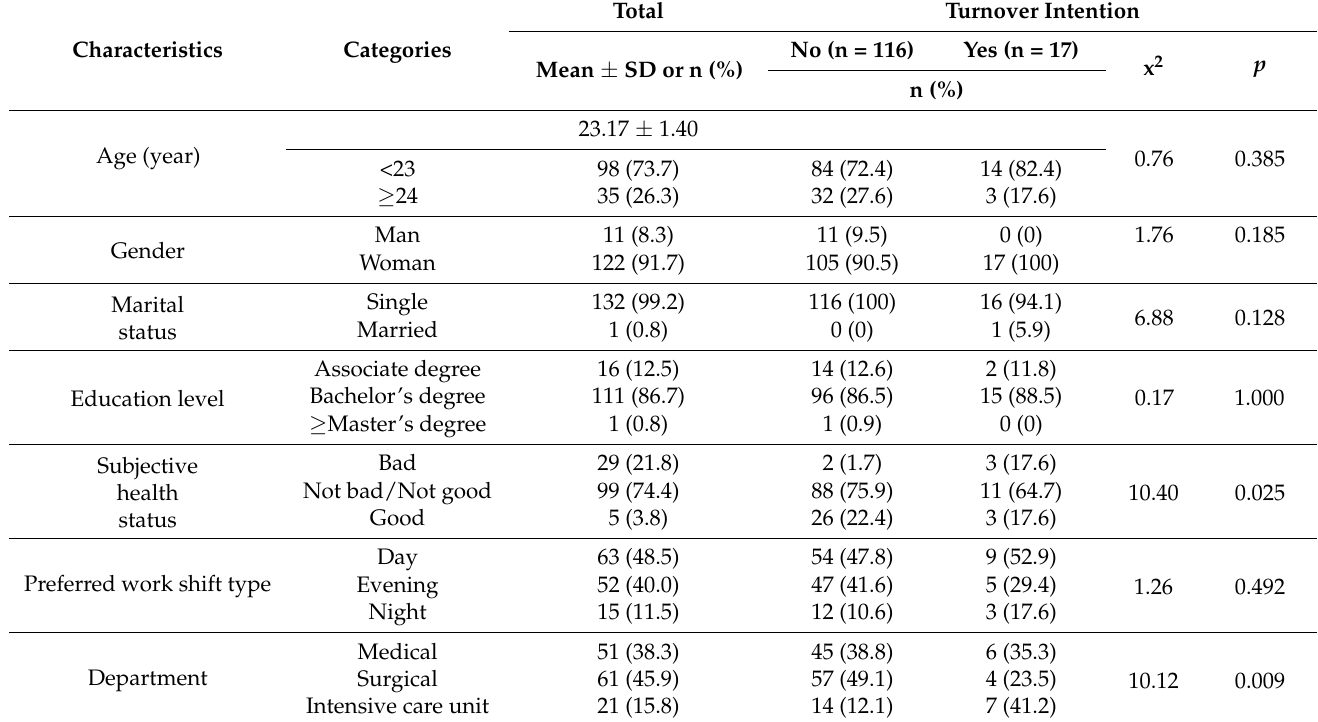
Table 1. Participants’ demographic and occupational characteristics ( N =